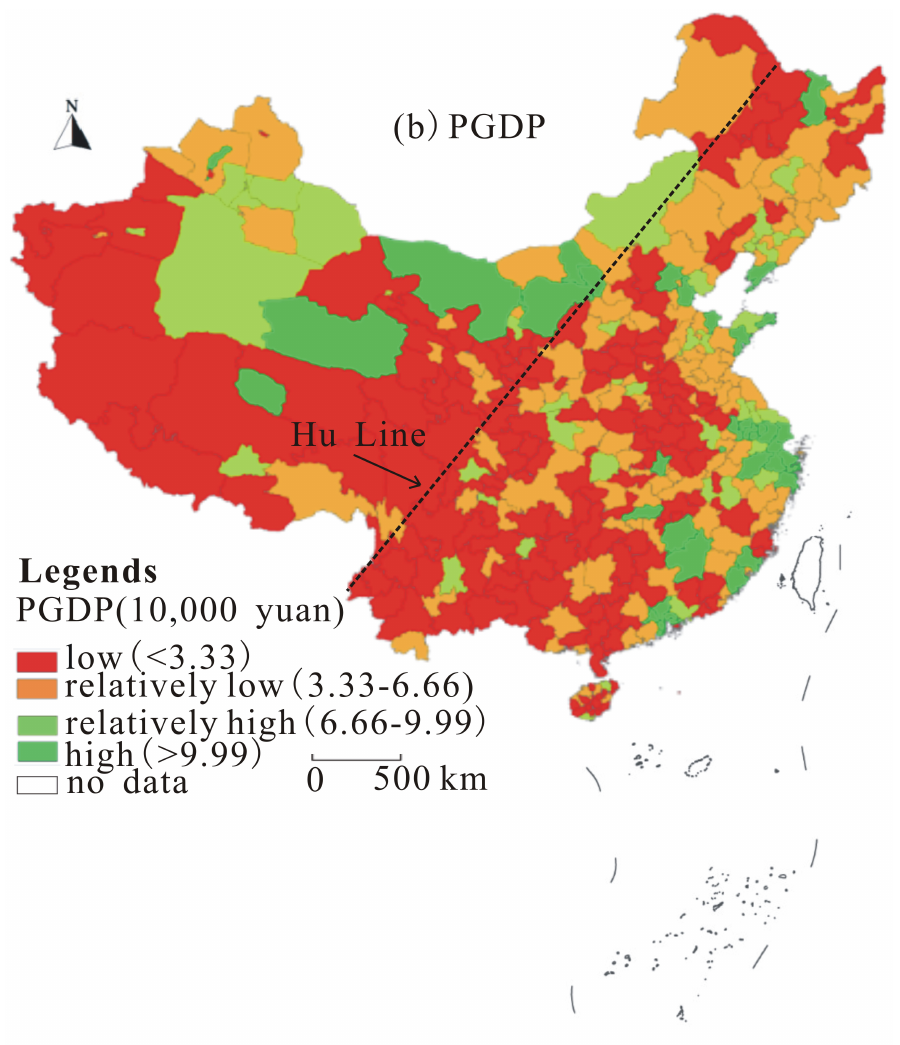
Figure 1. Spatial distribution characteristics of the PGEP and PGDP in the Chinese